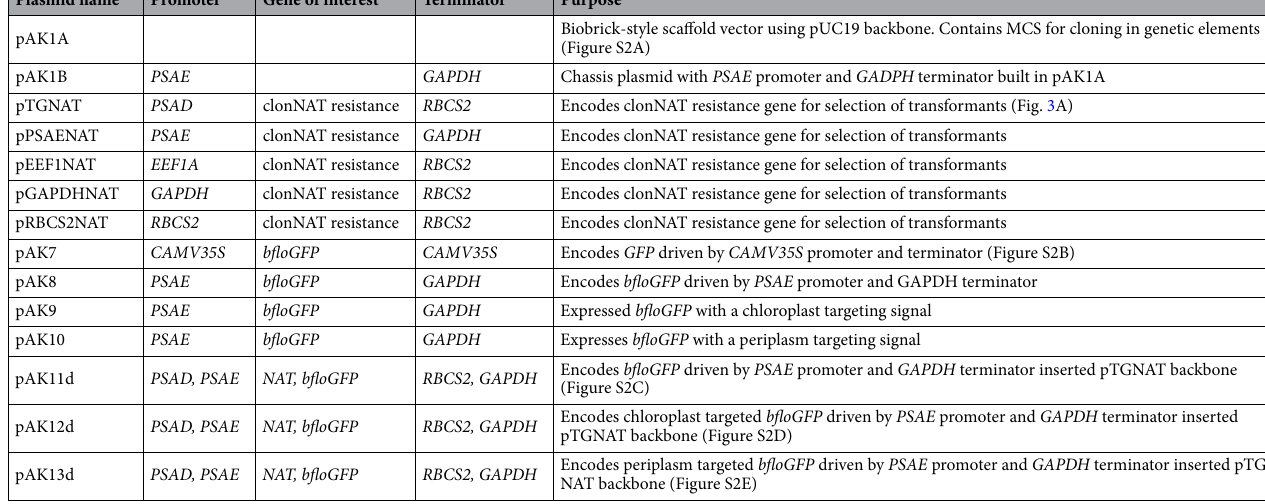
Table 5. Plasmids used in this